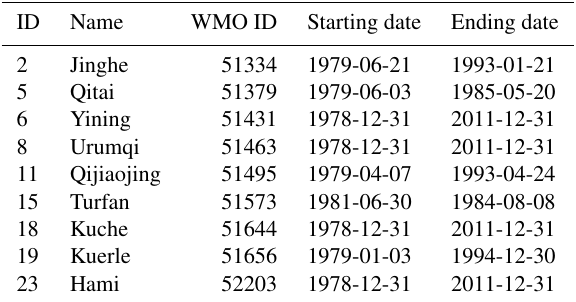
Table 2. Assimilated sites in ERA-Interim. The date format is year-